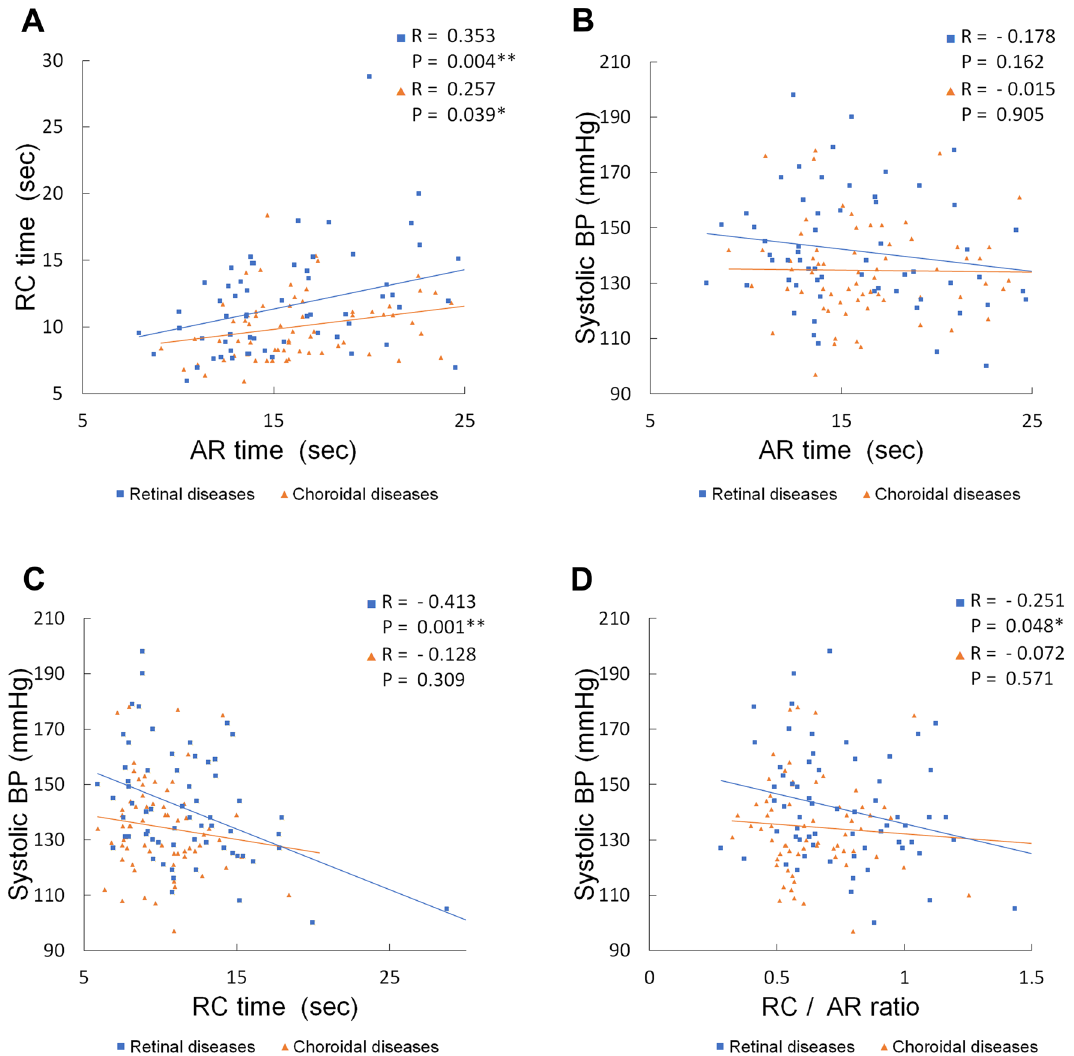
Figure 1. Correlation between arm-to-retina (AR) time and retinal circulation (RC) time, and systolic blood pressure (BP) and each parameter in patients with retinal diseases and choroidal diseases. ( A ) A positive correlation was observed between AR time and RC time in both groups. ( B – D ) Correlations between systolic blood pressure (BP) and each parameter. Although there was no correlation between systolic BP and AR time in either retinal- or choroidal-disease group ( B ), a negative correlation was observed between systolic BP and RC time ( C ), and systolic BP and RC/AR ratio ( D ) only in the retinal-disease group. **P < 0.01, *P < 0.05.